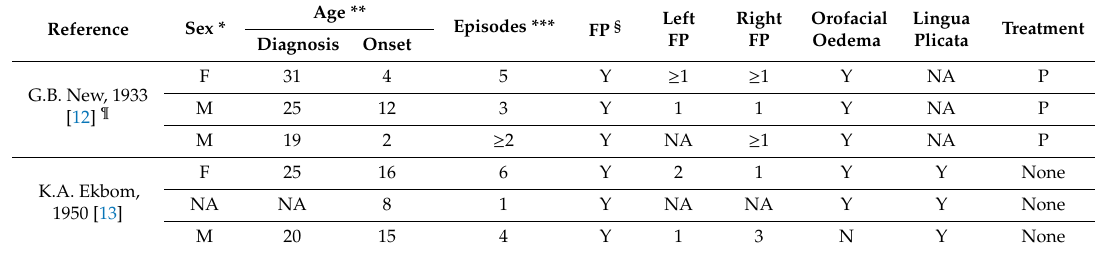
Table 1. Melkersson–Rosenthal syndrome in children and adolescents: literature review and case